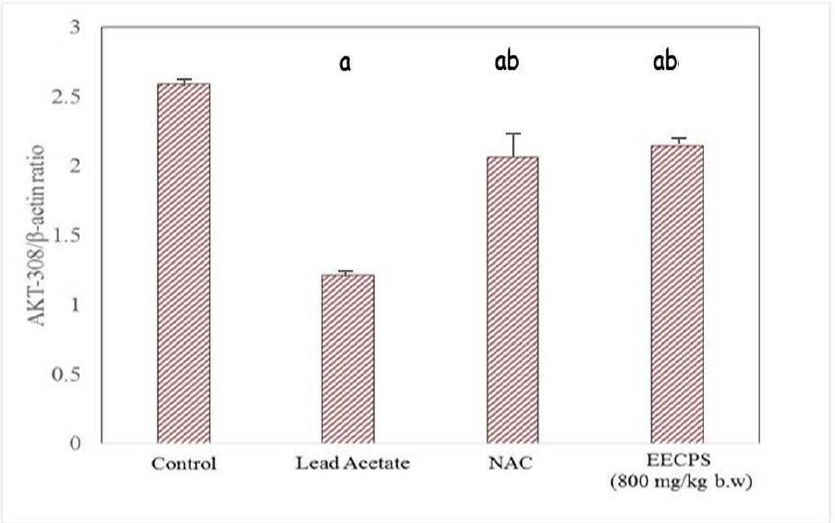
Figure 9. Graphical representation of AKT mRNA expression in the kidney. a Significantly different from the control group. b Significantly different from the lead acetate group.